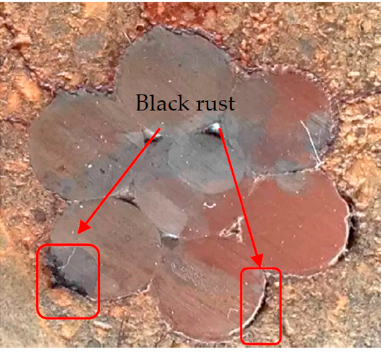
Figure 11. The black rust at the strand-concrete interface.